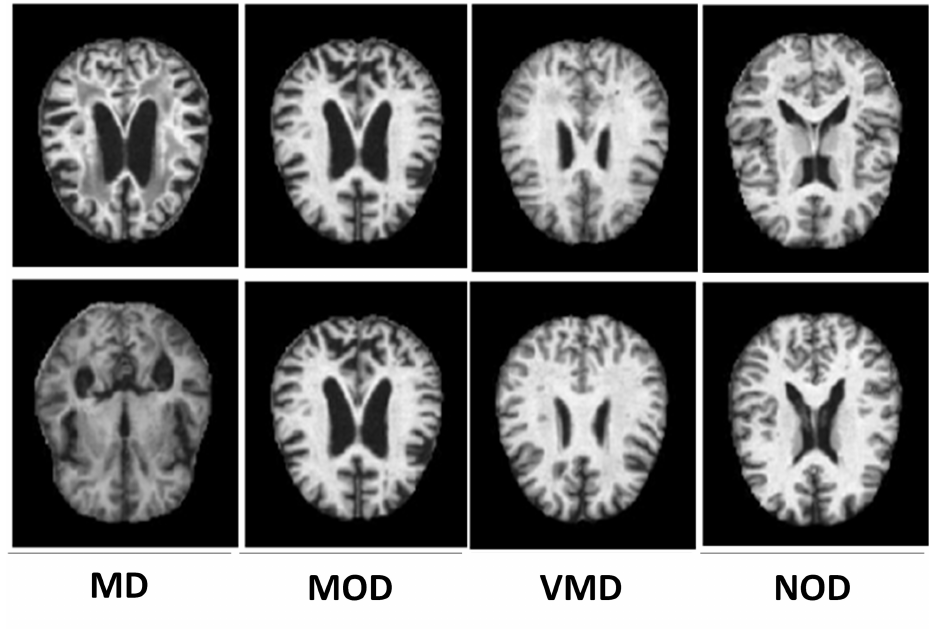
Figure 4. The synthetic image samples generated through ADASYN for all